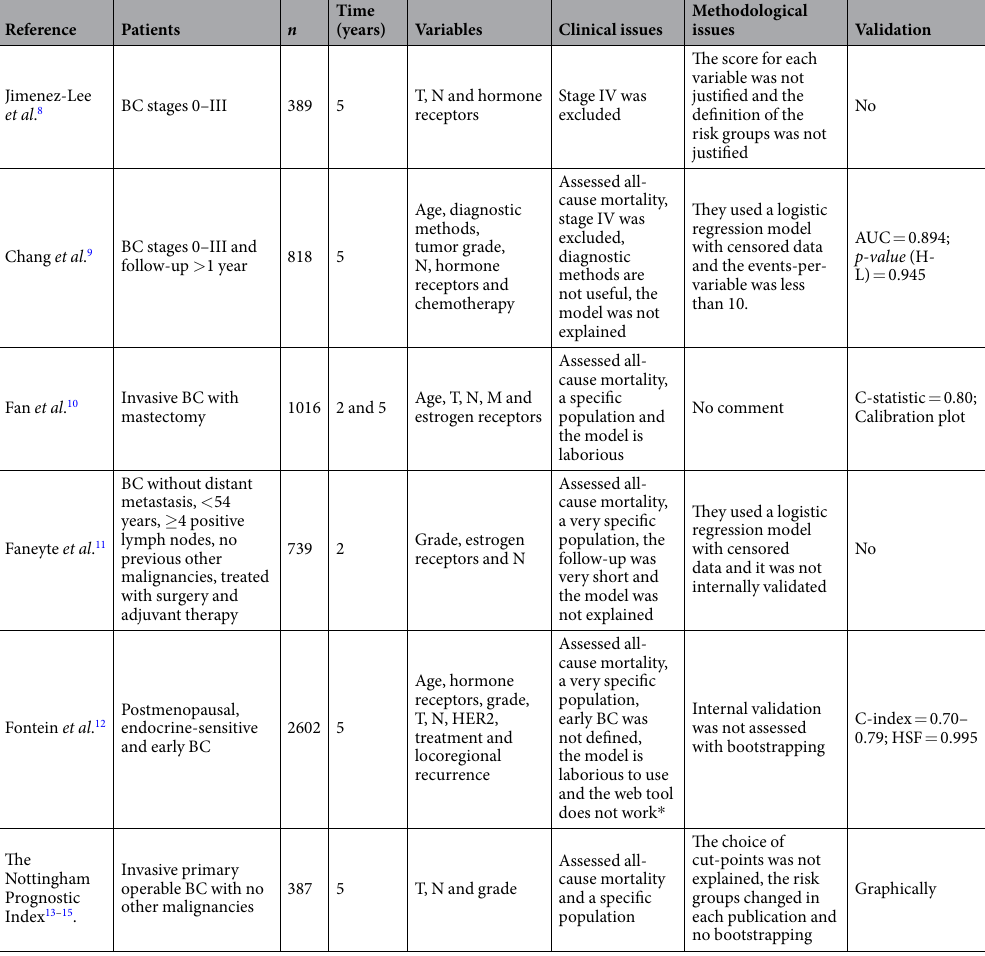
Table 1. Published predictive models for mortality in breast cancer patients. AUC, area under the ROC curve; BC, breast cancer; HER2, human epidermal growth factor receptor 2; HSF, heuristic shrinkage factor; H-L, Hosmer-Lemeshow test. * Tested in October